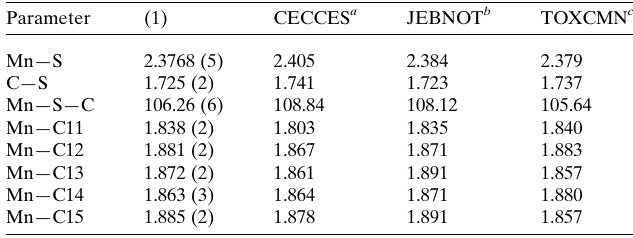
Table 4 Experimental details. Crystal data Chemical formula